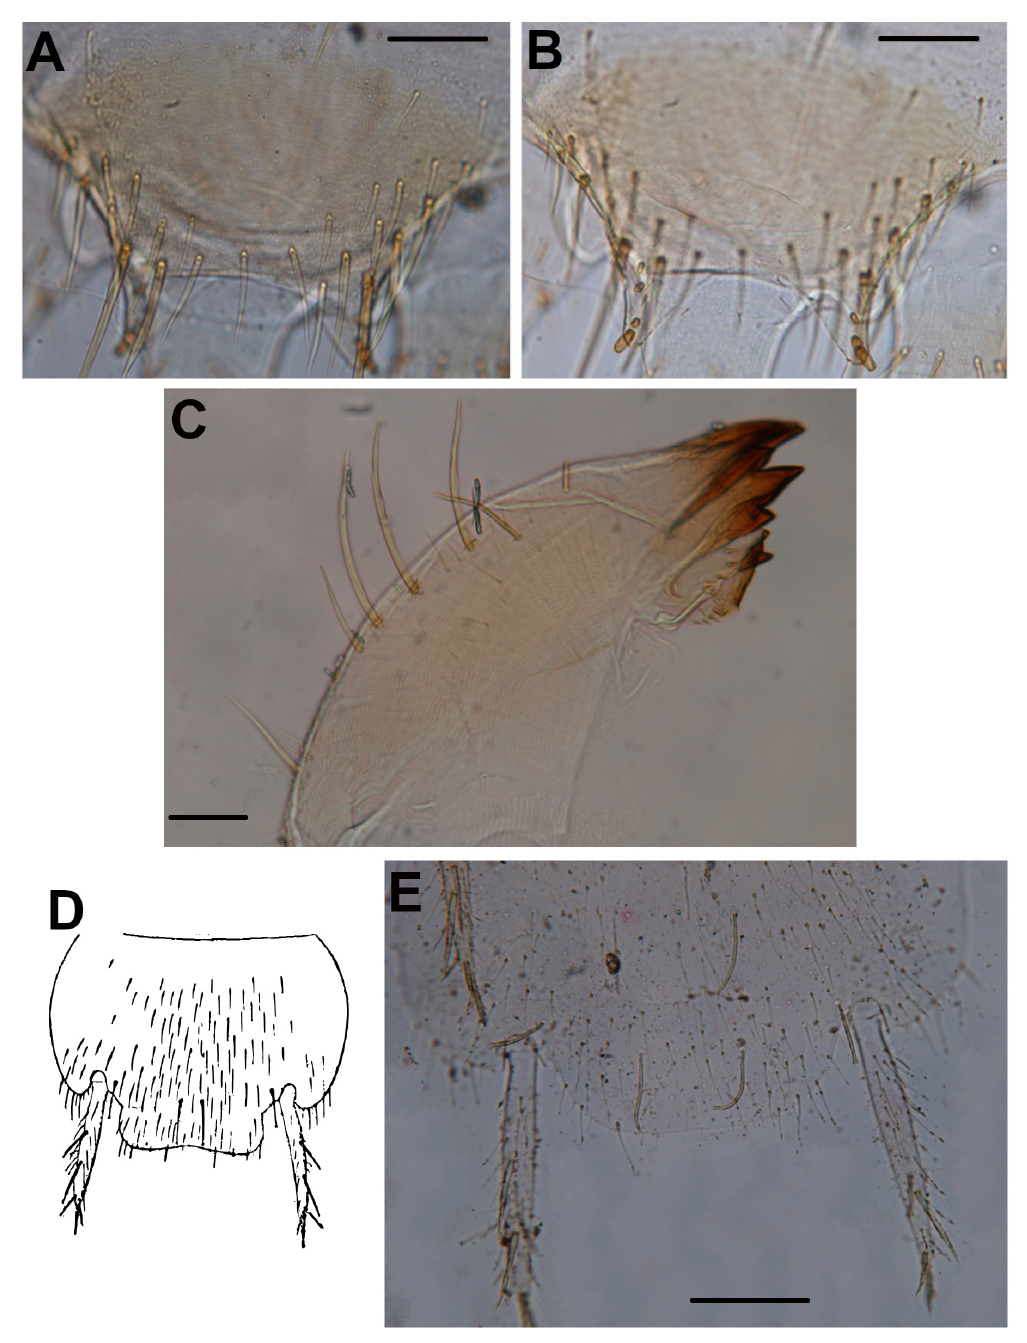
Fig 12. A–C . Coletinia mendesi Wygodzinsky, 1980, ♂ from Palenciana (Córdoba) (UCO, Ref. Z2643). A . Micrograph of the male urotergite X, focused dorsally. B . Idem ventrally; while the dorsal focus shows an almost straight hind margin, in the ventral focus a concave shape is visible between the posterolateral lobes. C . Micrograph of a mandible showing the macrochaetae of its outer margin, more numerous than in other species of the genus. D . Coletinia jeanneli (Silvestri, 1938), ♂. Urosternite VIII of the male according to the original design of Silvestri (1938). E . Coletinia tessella Molero, Bach & Gaju, 2013, ♂ from the type locality. Micrograph of urosternite VIII. Scale bars = 0.1